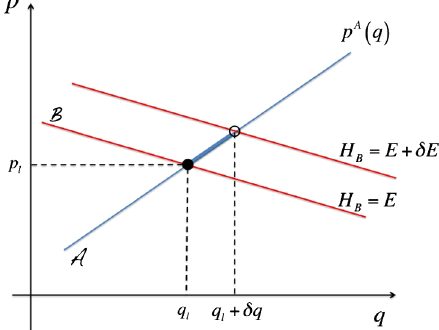
FIG. 4. The filled circle indicates an intersection between the closed curves A and B ; see Fig. 1. The open circle is an intersection point between A and a nearby energy shell, ¼ E þ δ E H B